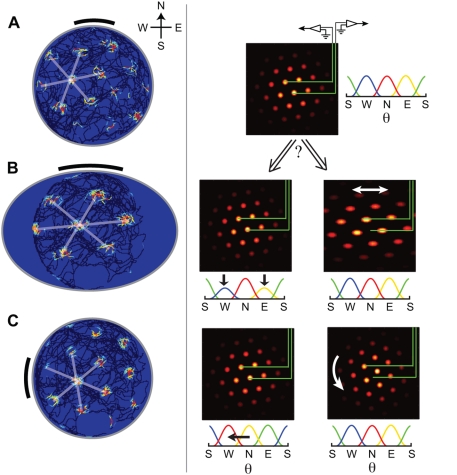
Tests of the continuous attractor hypothesis.Green lines represent the same fixed electrode locations in the
neural population, across all plots. (A) Left: Single-neuron
response. Right: Input head direction/velocity tuning curves, and an
instantaneous snapshot of the underlying population response, which
together produced the SN response on the left. (B) The SN grid
(left) expands along one direction when the amplitude of the head
direction/velocity inputs for that direction is lowered relative to
other directions (right, first panel), while the population patterns
remain unchanged. Alternatively, the same SN expansion could have
been produced by keeping the amplitude of the head
direction/velocity inputs fixed, if the population patterns were
stretched (right, second panel). The latter scenario is inconsistent
with the attractor hypothesis, because deformations of the pattern
are not part of the attractor manifold. In the former (continuous
attractor) scenario, the phase relationships between neurons is
preserved despite the SN expansion; in the second, phase
relationships must change. (C) The SN grid (left) rotates if the
head direction/velocity inputs to the network are rotated, while the
population remains unchanged. The same rotation could have been
produced by rotating the population pattern, but keeping the head
direction/velocity inputs intact. The latter possibility is
inconsistent with the attractor hypothesis. Again, the former
(continuous attractor) scenario can be distinguished from the latter
by whether phase relationships between neurons in the population are
preserved. (SN plots and the left column of population responses
were produced from a simulation with network parameters as in Figure
2D–F, and by appropriately scaling or rotating the
velocity/head direction inputs. Right population plots are
hypothetical.)